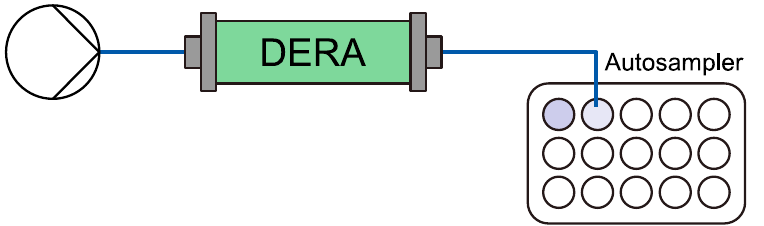
Figure 5. General flow setup. The reaction mixture containing hexanal ( 1 ) and acetaldehyde ( 2 ) in TEA puffer were pumped through a DERA-containing packed bed reactor. The product stream was collected afterwards by an autosampler.